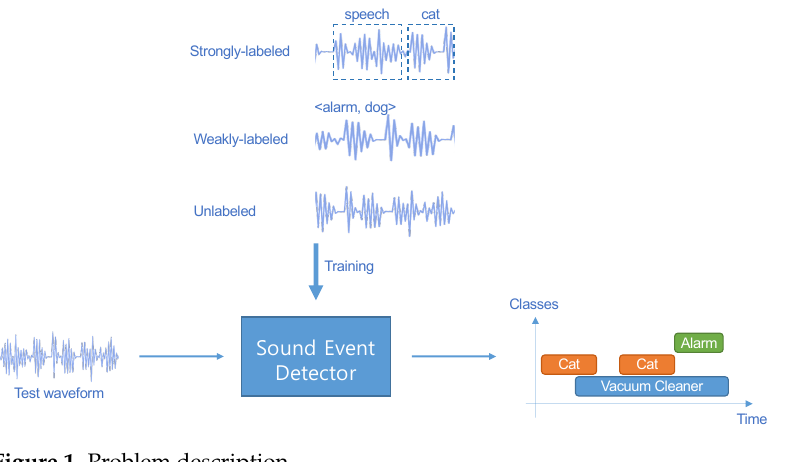
Figure 1. Problem